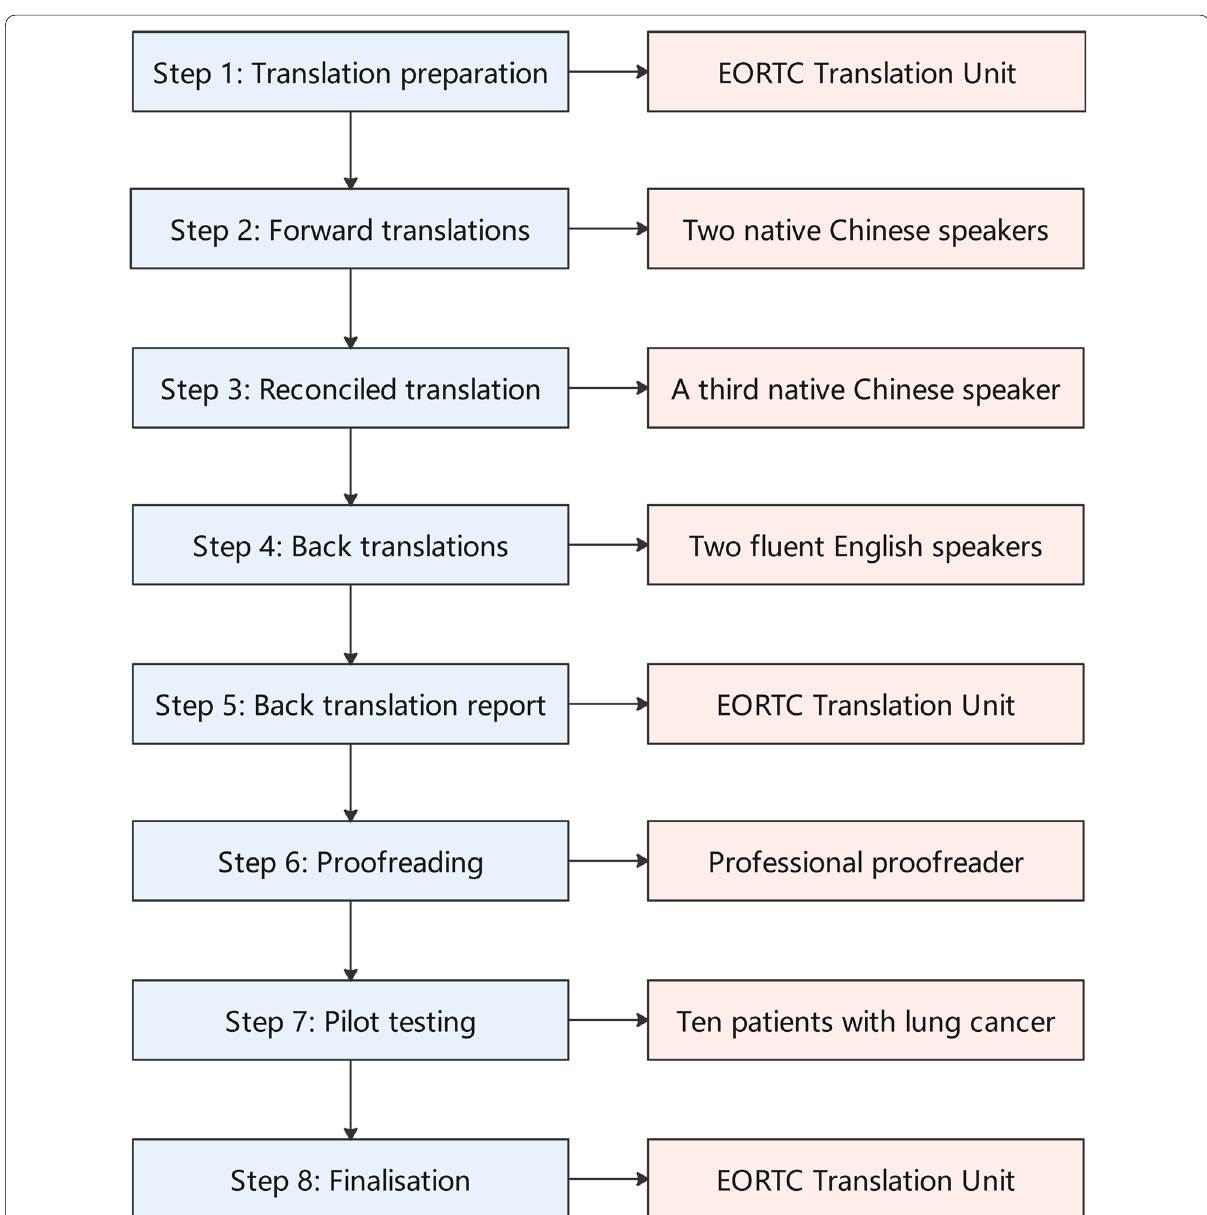
Fig. 1 Process used to translate and adapt the EORTC QLQ-LC29 into simplified Chinese. EORTC, European Organisation for Research and Treatment of Cancer; QLQ-LC29, Quality of Life Questionnaire-Lung Cancer